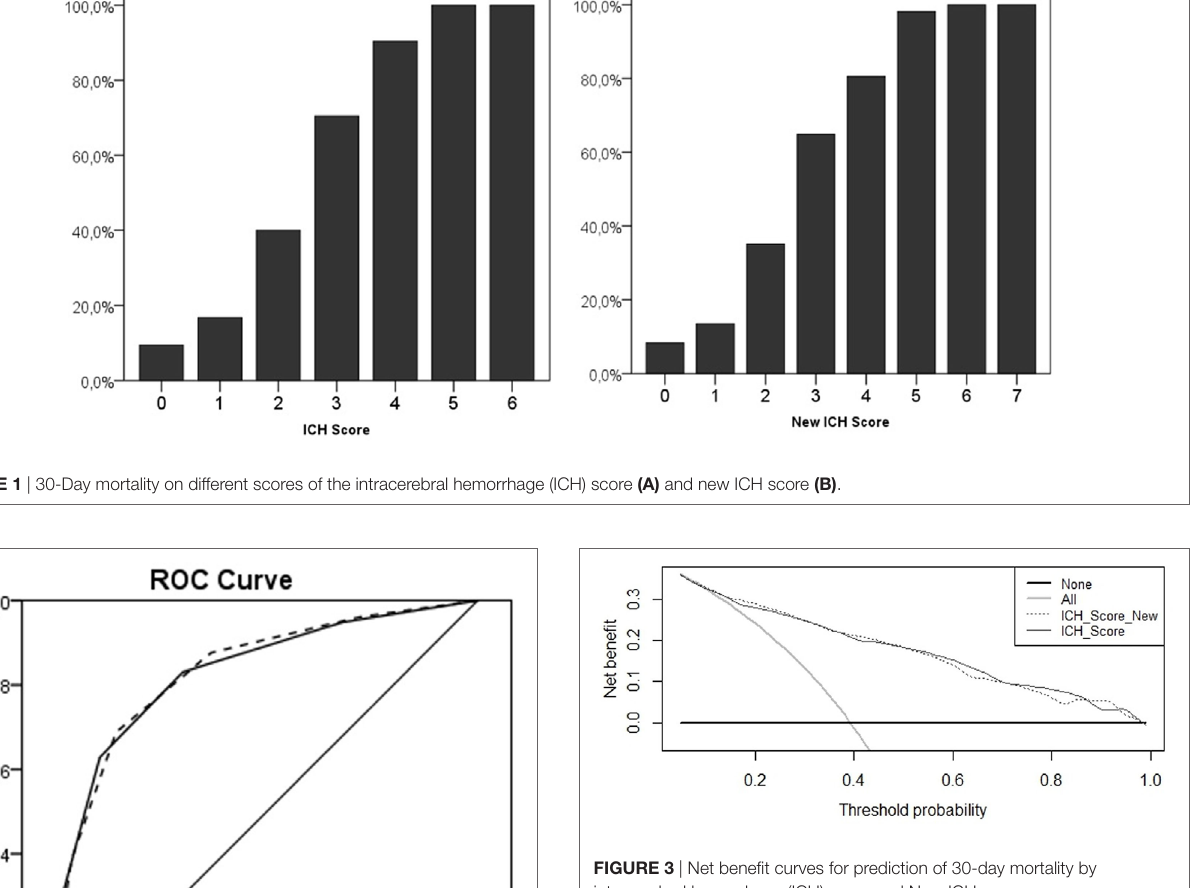
FigUre 3 | Net benefit curves for prediction of 30-day mortality by intracerebral hemorrhage (ICH) score and New ICH score.